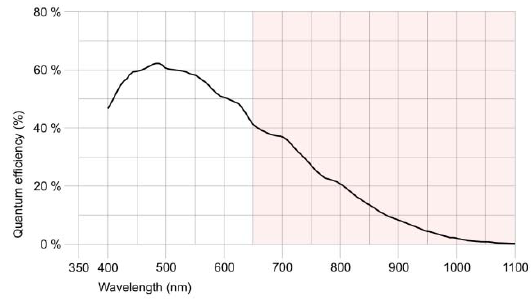
Figure 6. Spectral sensitivity curve for the UI 5480CP-M-GL sensor from manufacturer’s data.